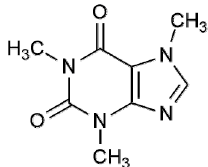
Figure 1. The chemical structure of 1,3,7–trimethylxanthine (caffeine).